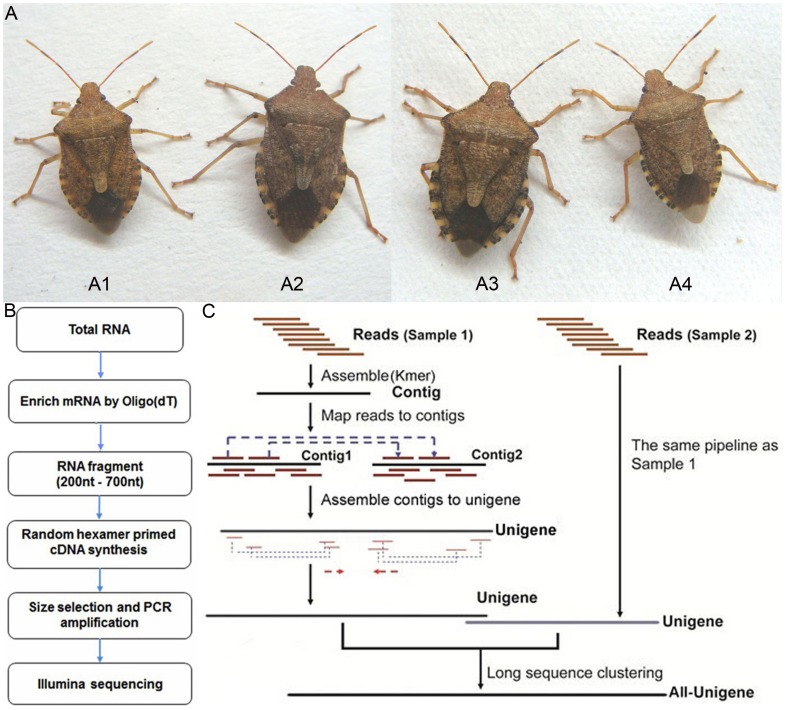

Arma chinensis fed with different diets and schematics of the transcriptome sequencing analysis.(A) Female adults fed with artificial diet (A1) and Chinese oak silk moth pupae (A2); male adults fed with artificial diet (A4) and Chinese oak silk moth pupae (A3). (B) Experiment pipeline of transcriptome. (C) Assembly process of the data.